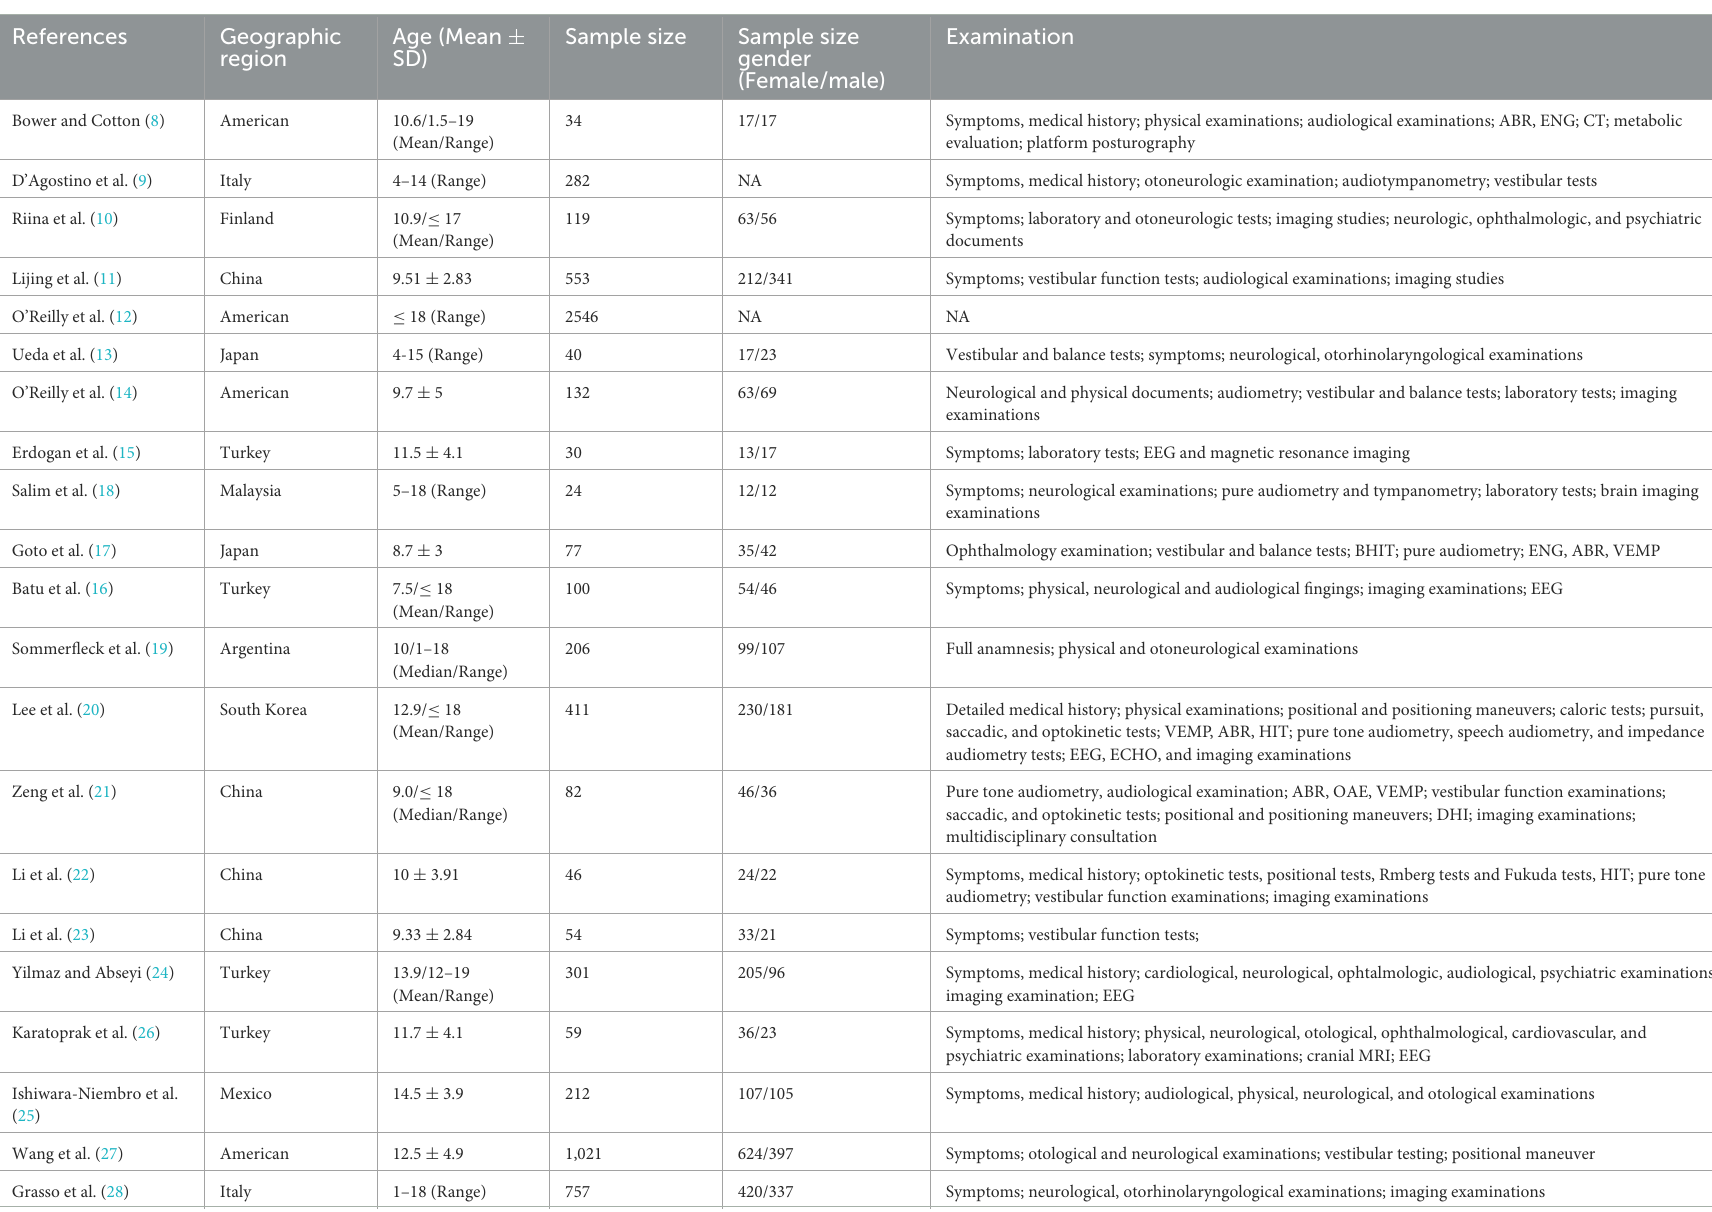
TABLE 1 Baseline characteristics of included